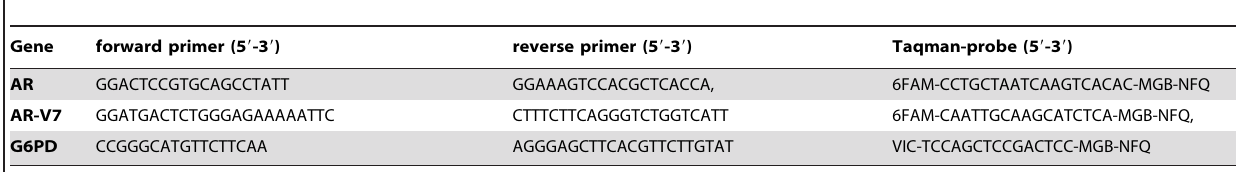
Table 1. Primers and Probes for